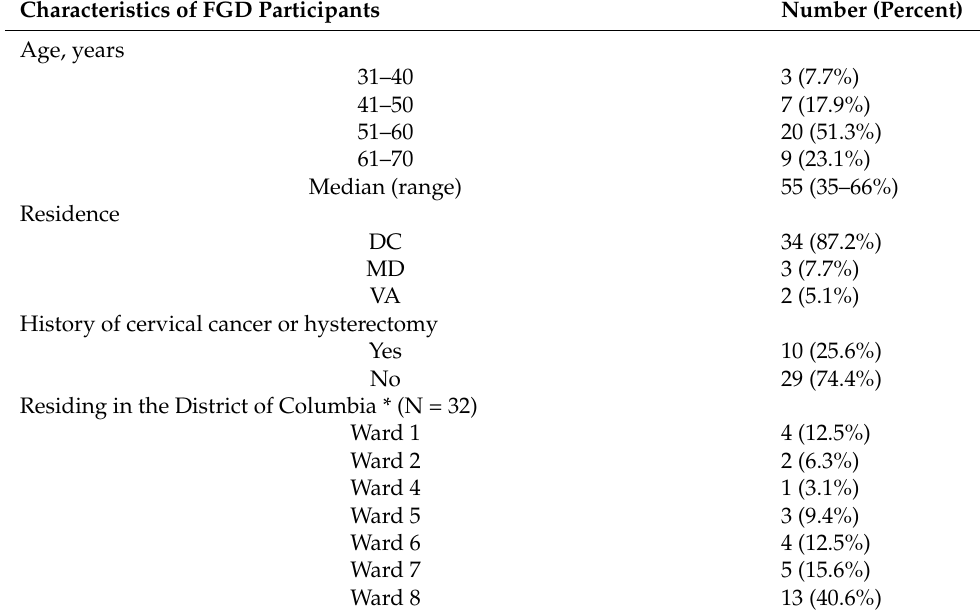
Table A1. Characteristics of women living with HIV who participated in the focus group discussion (n =